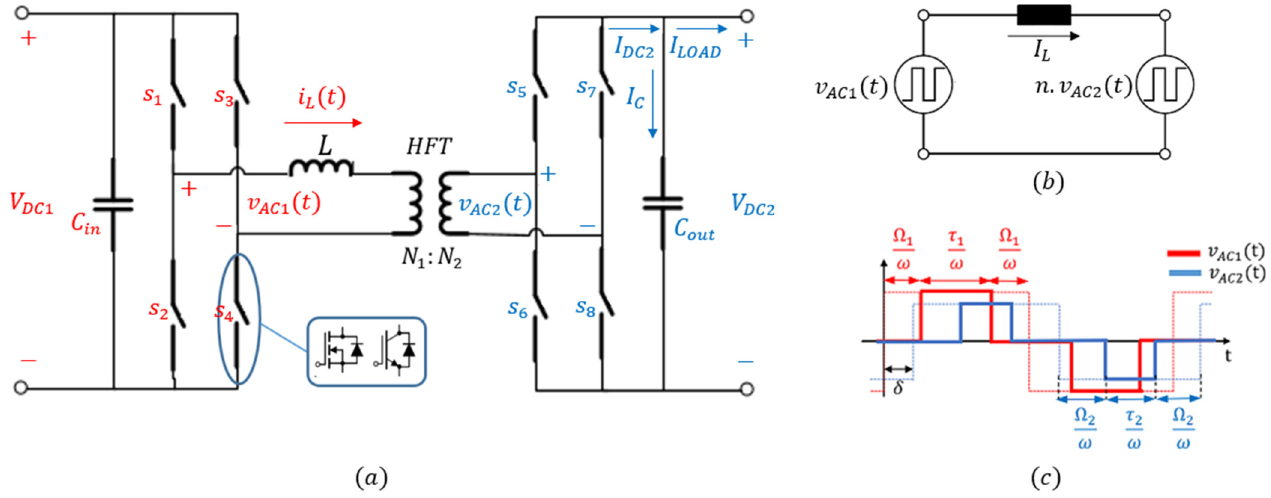
Figure 2. DAB converter ( a ) topology, ( b ) lossless DAB model, ( c ) voltage waveforms v AC 1 ( t ) and v AC 2 ( t )